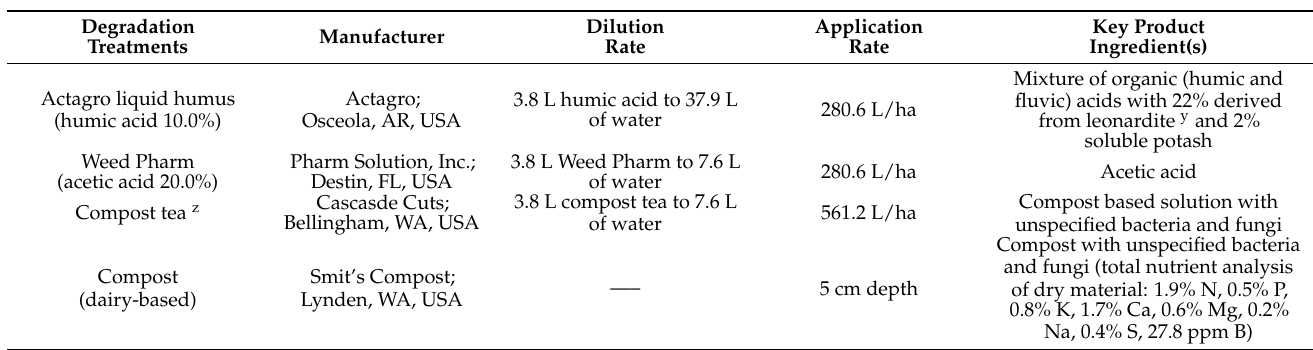
Table 2. Degradation product treatments surface-applied to soil-biodegradable mulches (BDMs) to enhance surface deterioration and in-soil degradation in a field study in northwestern